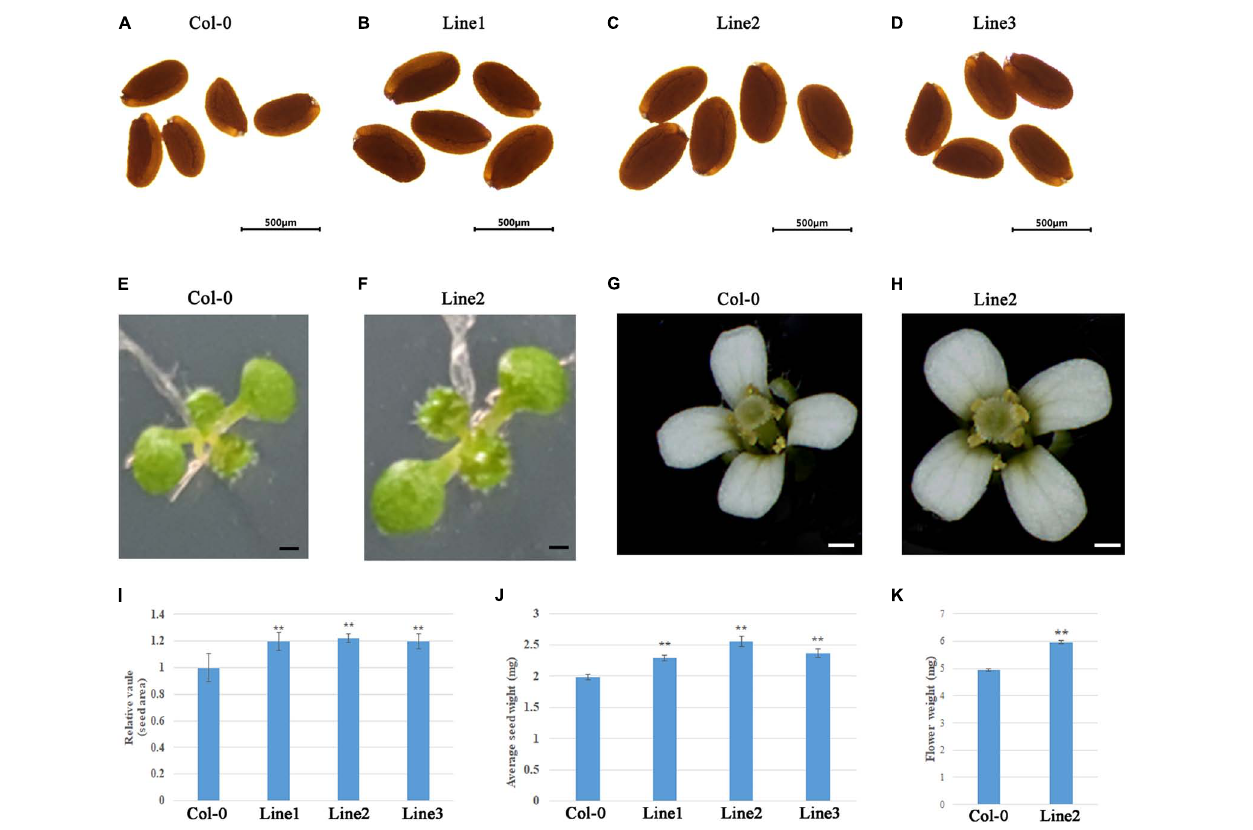
FIGURE 6 | The overexpression of GhDA1-1A R 301 K increases the weight and size of the seeds. (A-D) The seeds from transgenic plant lines were compared to seeds from CK. Bar = 500 µ m. (E) Nine-day-old seedlings of Col-0 (E) and transgenic plant lines 2 (F) . Line2 has larger cotyledons than Col-0. ((G,H)) Flowers of Col-0 (G) and Line2 (H) . (I) The relative area of seeds from Col-0 and three transgenic plant lines. (J) Average 1000-seed weights of the CK and transgenic plant lines. Values represent the mean ± standard error from three independent samples. (K) Mass of five fresh flowers. **represents significant differences at the P < 0.01 level.